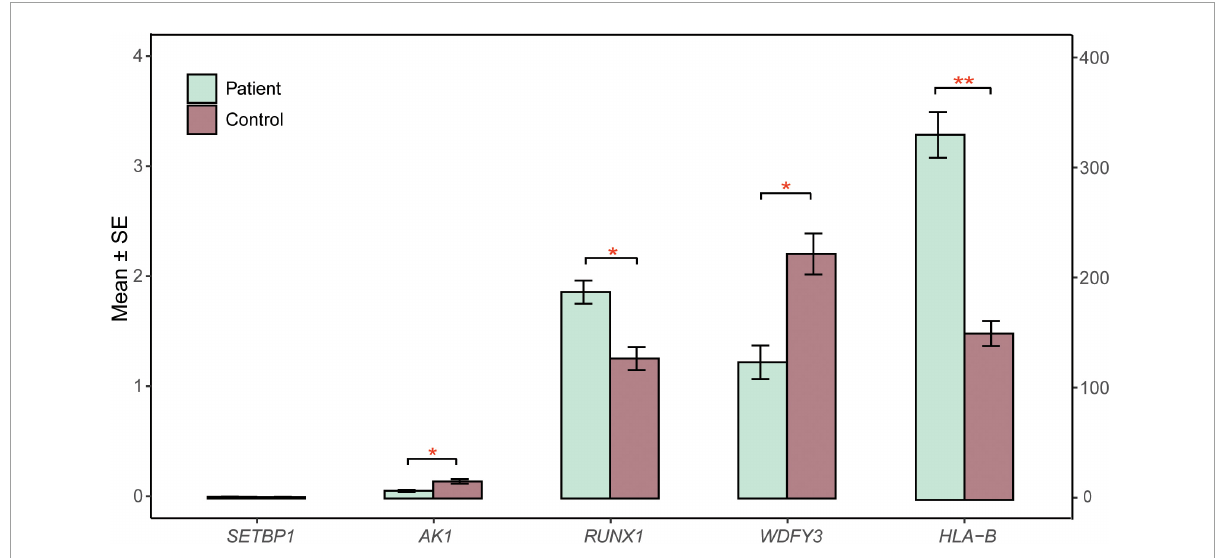
FIGURE4 RT-qPCR validation. The relative expression of candidate genes ( SETBP1, WDFY3, AK1, RUNX1, HLA-B ) in patient and control blood cells was quantified by RT-qPCR. β -Actin mRNA was used as an internal control. The experiments were performed in triplicate. Data are shown as the mean ± SE. Two sample t -test was performed to test whether the expression of these genes between case and control are significant difference or not. Statistical significance is presented relative to control as * P < 0.05 and ** P < 0.01. The X -axis on the left presents the mean expression of the SETBP1 , WDFY3 , AK1 , and RUNX1 genes. The X -axis on the right presents the mean expression of the HLA-B gene. SE, standard